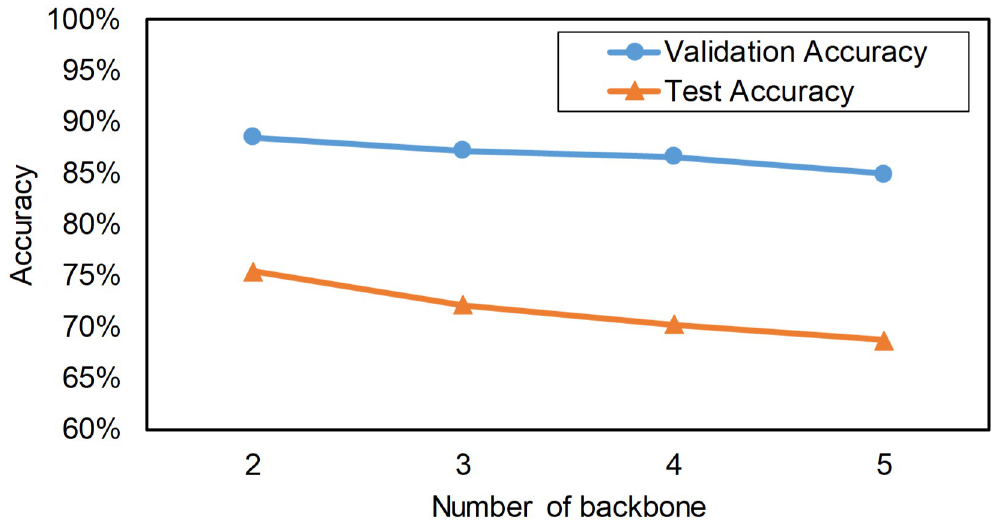
Fig 7. Number of backbones ensembled and their detection precisions.